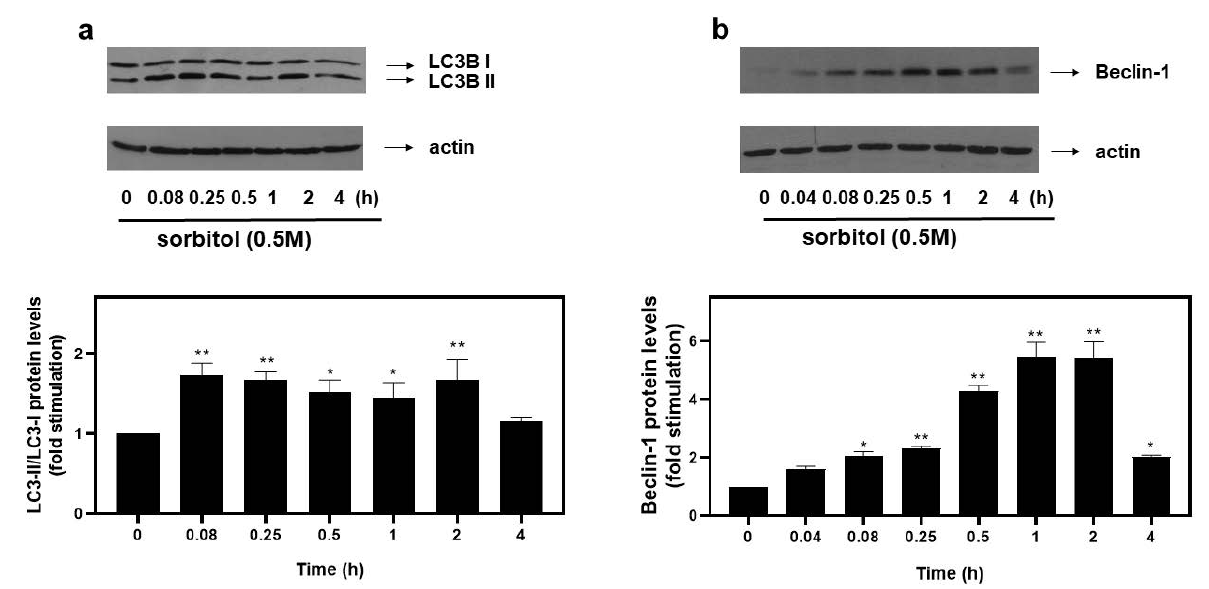
Figure 2. Hyperosmotic stress induces an increase in autophagic markers in H9c2 cardiac cells. H9c2 cells were exposed to 0.5 M sorbitol for the times indicated. Protein extracts (40 µ g/lane) were subjected to SDS-PAGE and immunoblotted with antibodies for endogenous levels of total LC3B protein (LC3 I and LC3 II forms) (( a ) upper panel), actin (( a , b ) bottom panels) and total levels of Beclin-1 (( b ) upper panel). Western blots presented are representative of at least three independent experiments with overlapping results. Immunoreactive bands were quantified by scanning densitometry and plotted (( a , b ) respective graphs). Results are means ± SEM for at least three independent experiments. * p < 0.05 and ** p < 0.01 compared to control